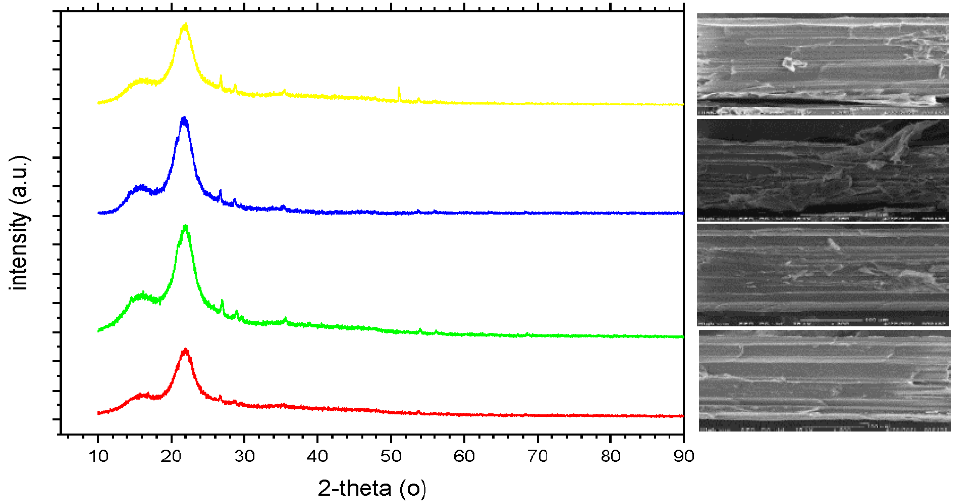
Figure 7. Intensity comparison of the XRD test of BSFs (TP, P1J, P2J, and P3J). The changing trend of TP, P1J, P2J, and P3J fibers increased the crystallization index in the fiber along with treatment time. A longer treatment time makes the fiber crystalline index higher. The fiber crystallization index increases due to changes in the structure of the fiber, and it can change the micromechanics properties of the fiber. SEM results in Figure 4 can be analyzed for crystal size using ImageJ software as shown in Figure 8: